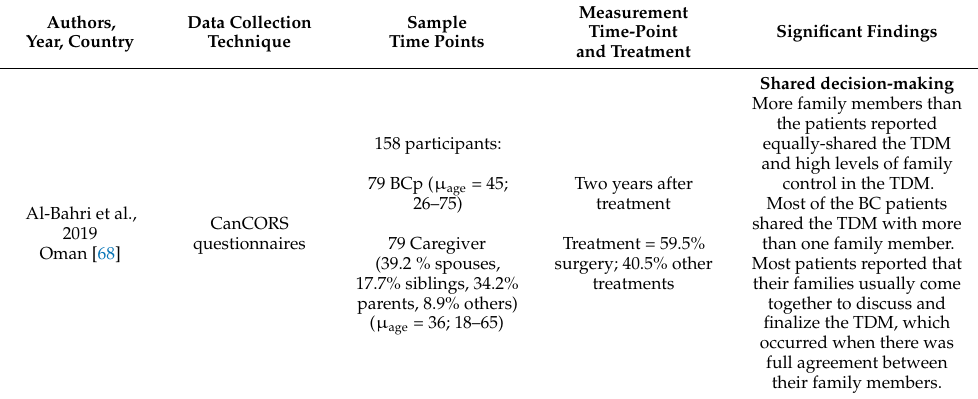
Table 4. Mixed methods